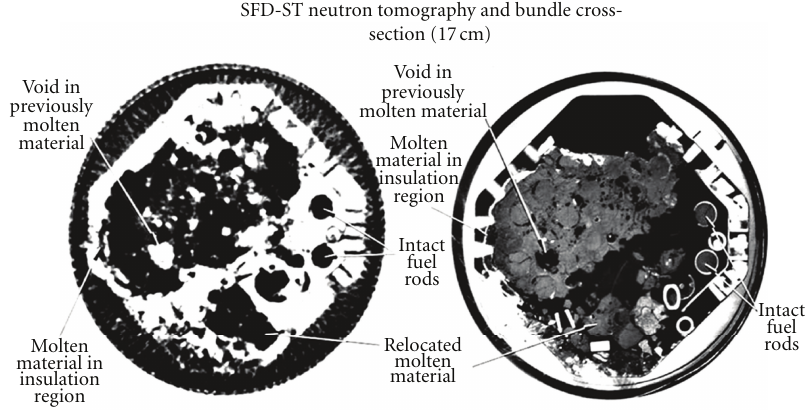
Figure 3: Horizontal metallographic cross-sections from PBF-SFD-ST showing blockage formation after { U-Zr } -O 2 melting and relocation.